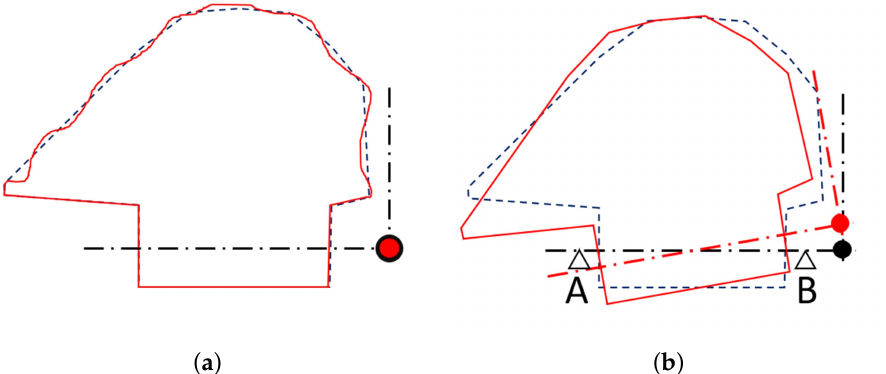
Figure 6. ( a ) Effect of tolerances chain considering only those from the downstream axis of the structure. ( b ) Effect of tolerances chain considering only those from the upstream axis, passing through the bearings’